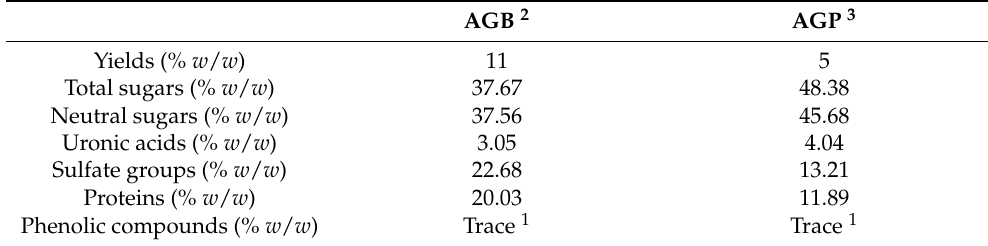
Table 1. ChemicalanalysisandextractionyieldsofAGBandAGPfractionsfromgreenseaweed C. decorticatum . AGB 2 AGP 3 Yields (% w / w ) Total sugars (% w / w )